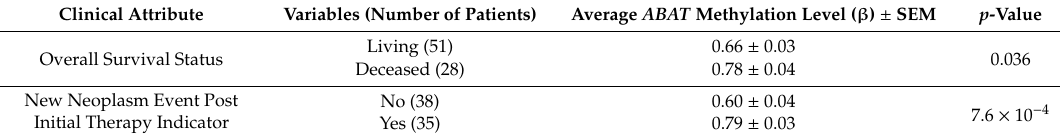
Table 3. Correlations between ABAT methylation levels and clinical